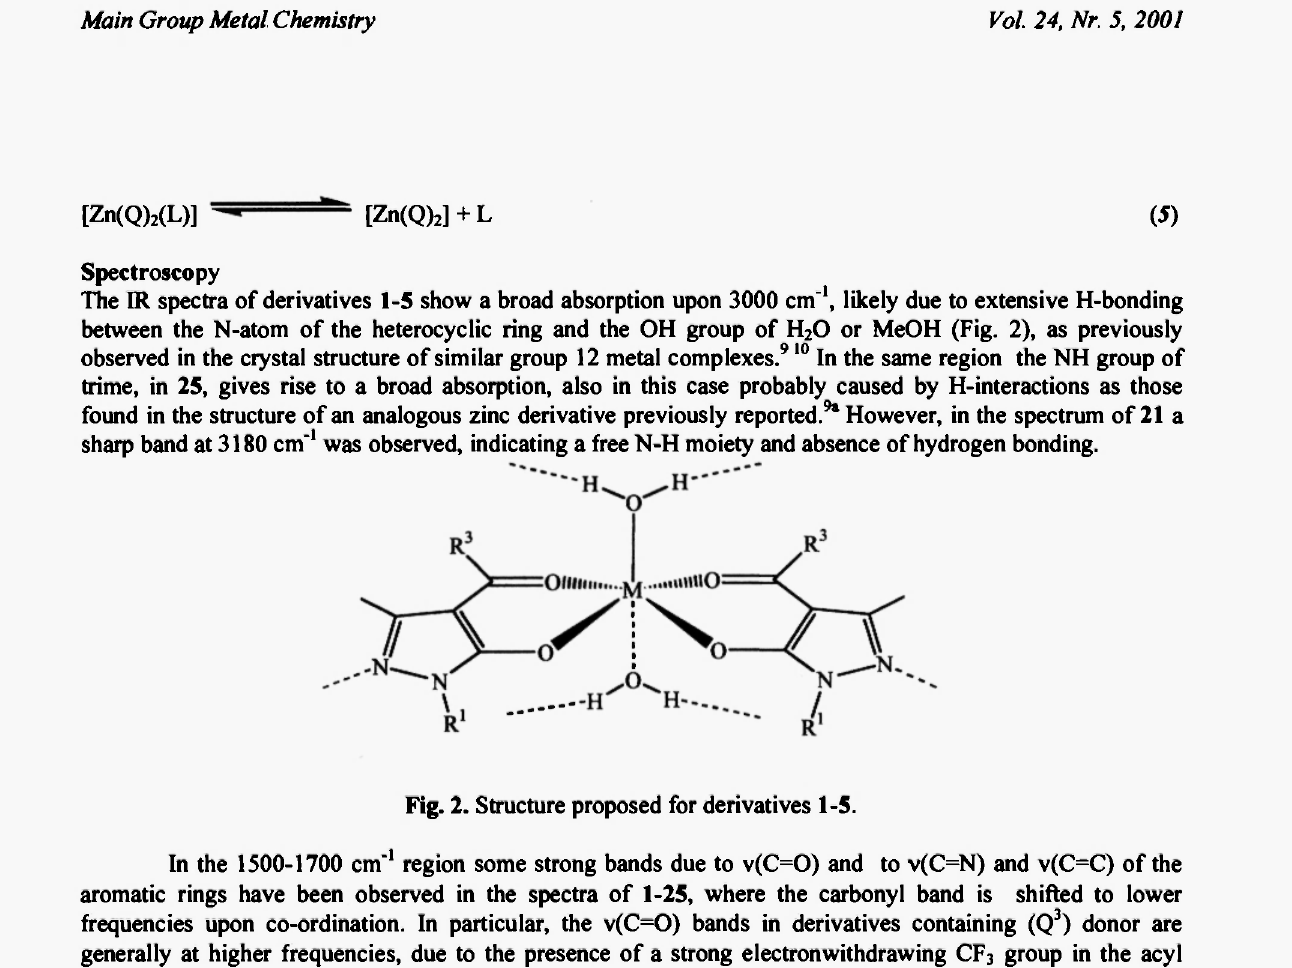
Fig. 2. Structure proposed for derivatives